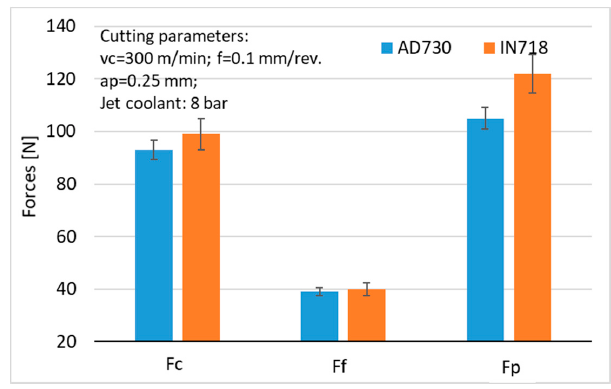
Figure 5. Cutting forces generated by AD730 ® and IN718 in the turning process.